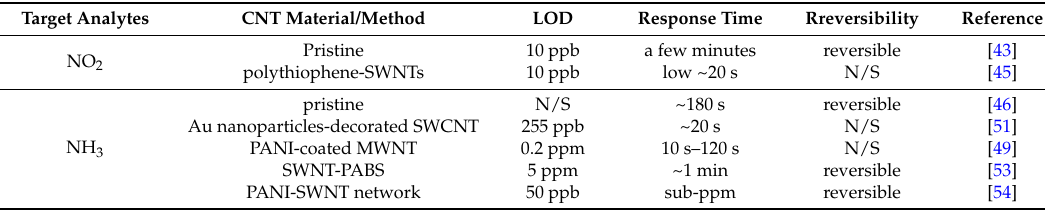
Table 1. Summary of sensing performance of chemiresisitive